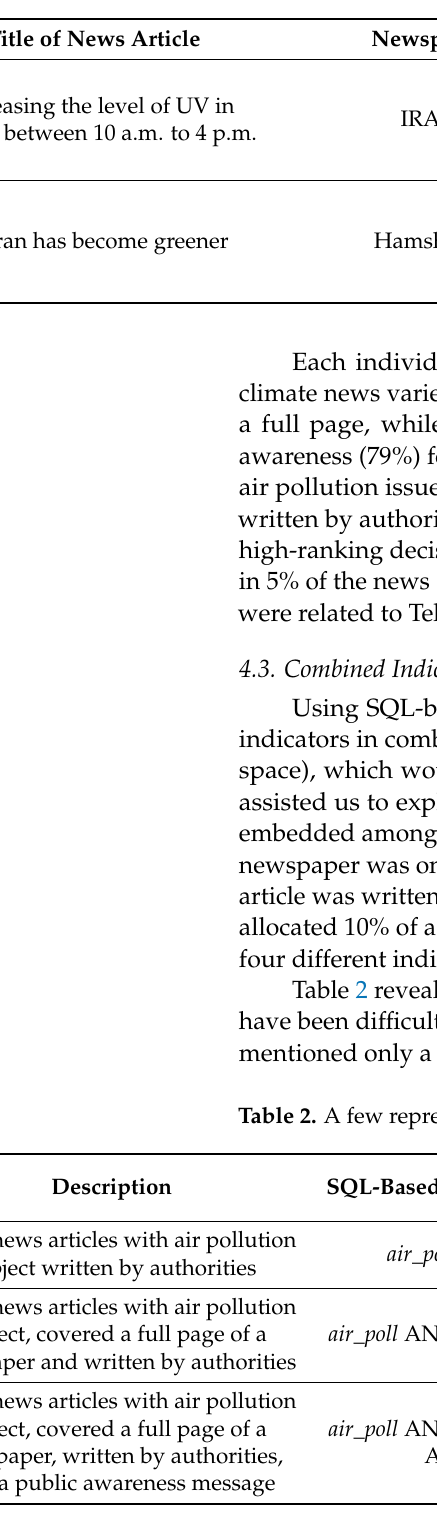
Table 1. Typical news articles on Tehran with climate subject (translated to English).